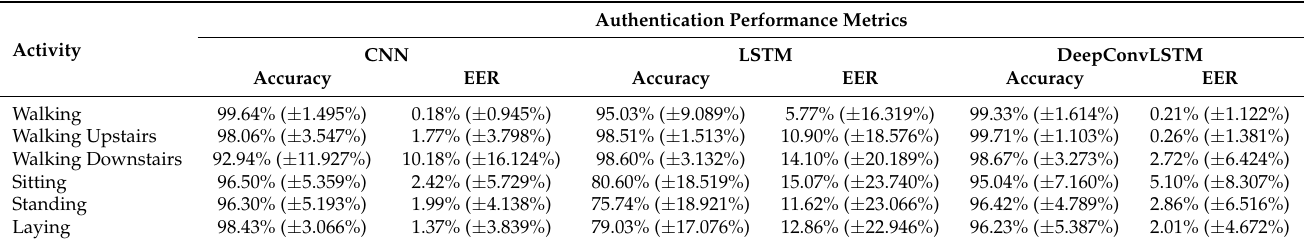
Table 8. Average metrics on classifier evaluation of deep learning models using UCI-HAR dataset.